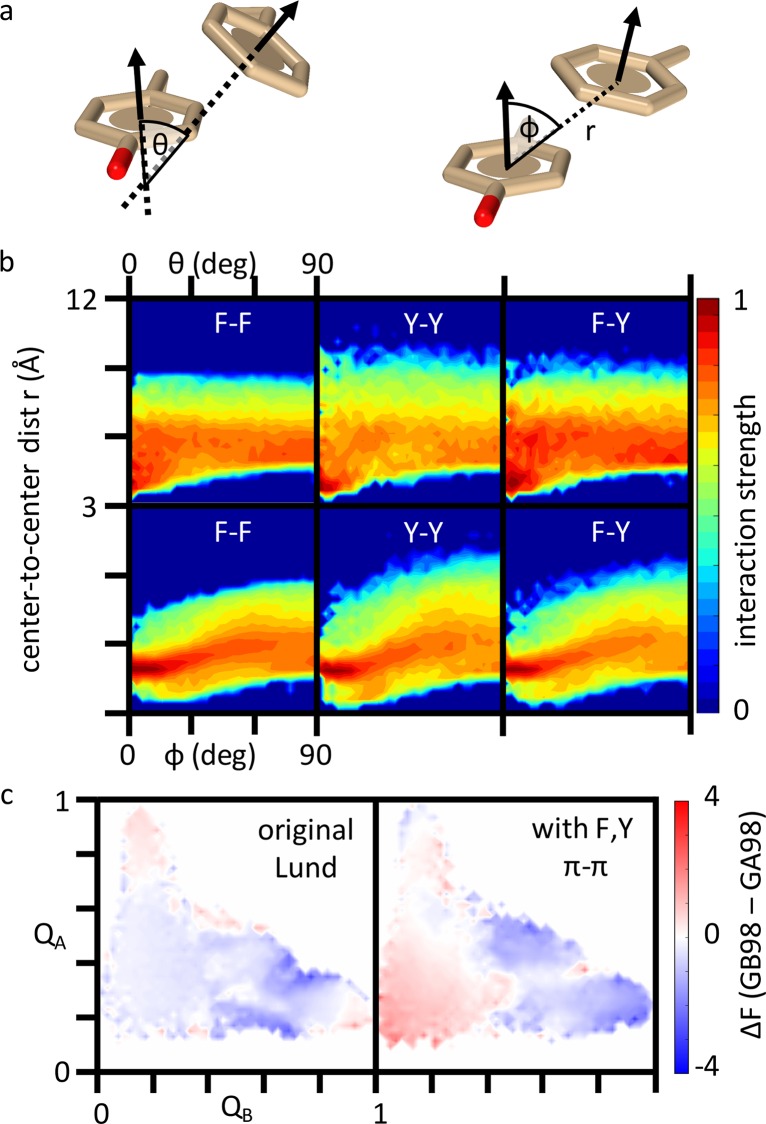
Effect of a rudimentary π-π potential for Phe (F) and Tyr (Y) residues on the GA/GB switch.(a) Three geometric variables are used to characterize the relative position and orientation of a pair of aromatic rings in F or Y: center-to-center distance r (spatial separation between the centers of the two rings), planar tilt angle θ, and center dislocation angle φ. (b) PDB statistics for F-F, Y-Y, and F-Y contacts were used to derive an interaction strength of the π-π potential as a function of r, θ, and φ. The vertical variable here corresponds to |Eππ(r, θ, φ)/εππ| defined in Methods. (c) Difference landscape for the L45Y mutation. Free energy of GB98 minus free energy of GA98 as a function of QA and QB computed in our hybrid model with two different transferrable components: the original Lund potential (left), and the modified potential (right) that incorporates the F,Y potential with interaction strengths given in (b) and εππ = 1.5.